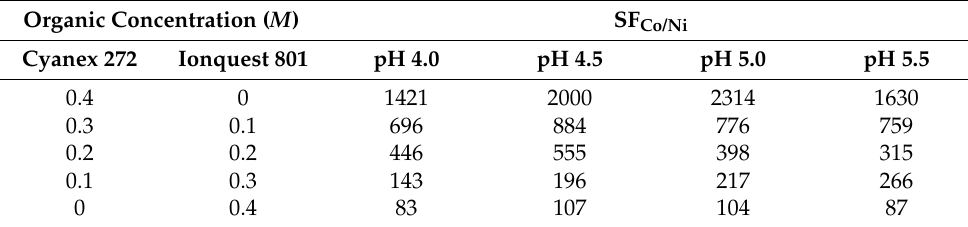
Table 6. Separation factor of cobalt over nickel (SF Co/Ni ) under various organic compositions and pH values. Organic Concentration ( M